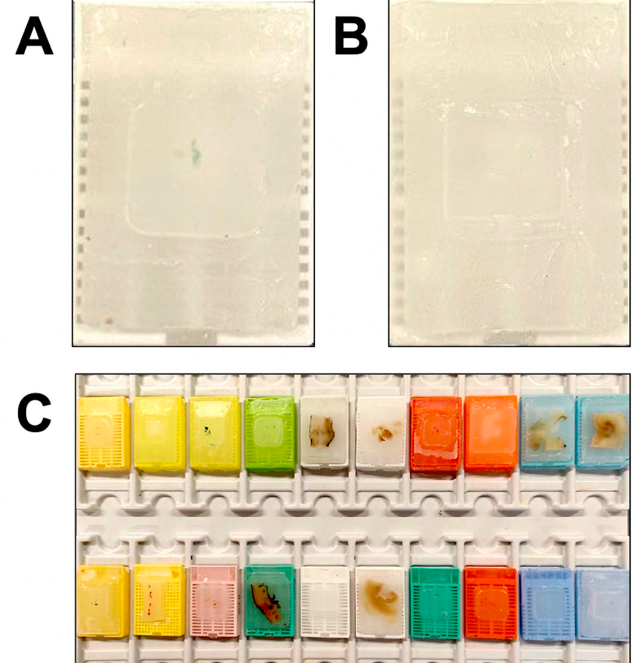
Figure 2. Representative images of FFPE tissue blocks inadequate for NGS analysis due to ( A ) scarcity of material ( B ) and absence of material following previous sectioning for diagnostic purposes. ( C ) A hub center for NGS-based molecular diagnostics receives different types of FFPE tissue specimens (i.e., biopsy, surgical resection and cytology specimens) obtained with different workflows and processes.